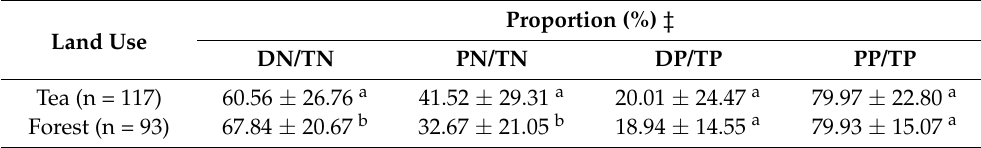
Table 3. Proportions of the dissolved and particulate in the total nitrogen and phosphorus concen- trations in the surface runoff in the tea and forest systems.